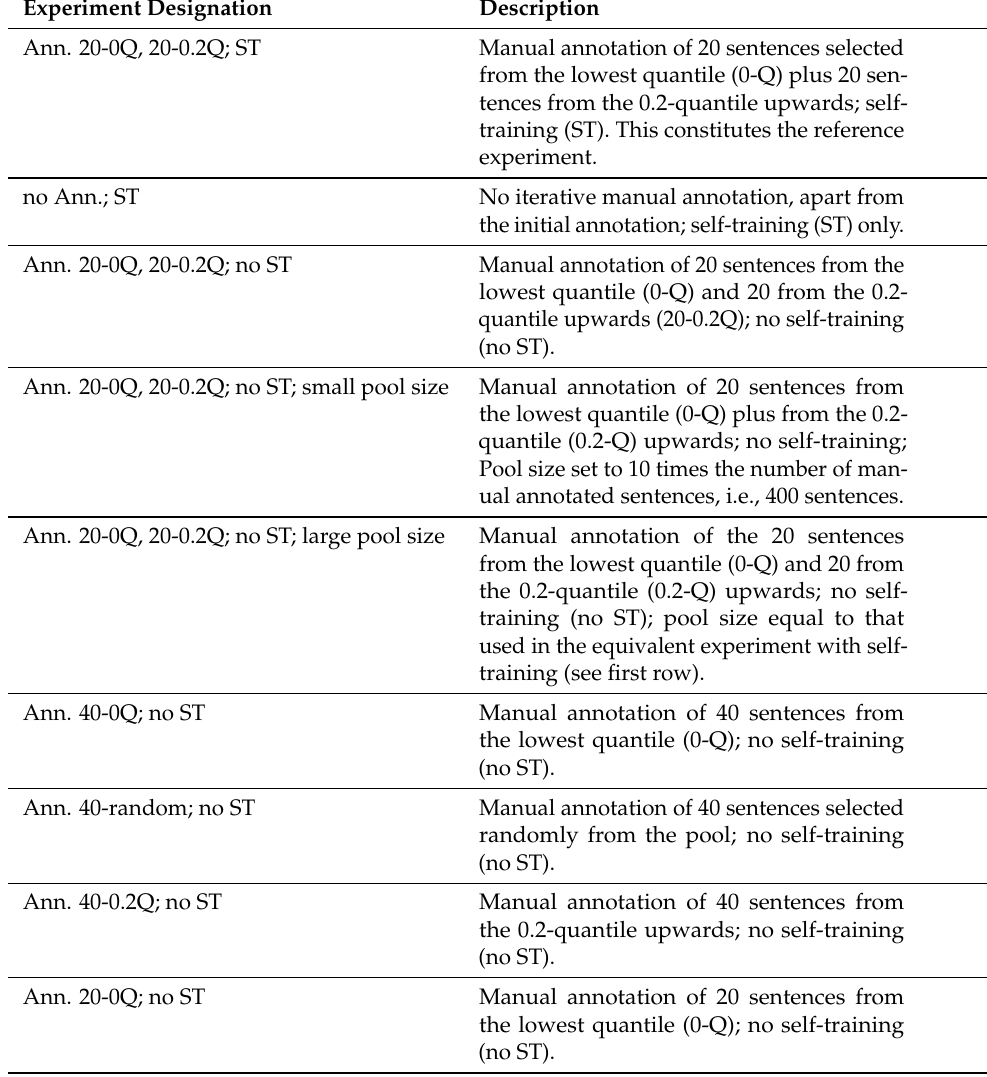
Table 3. Description of the different experiments conducted to evaluate the effect of self-training, the number and selection of sentences for manual annotation, and the pool size of the model training for